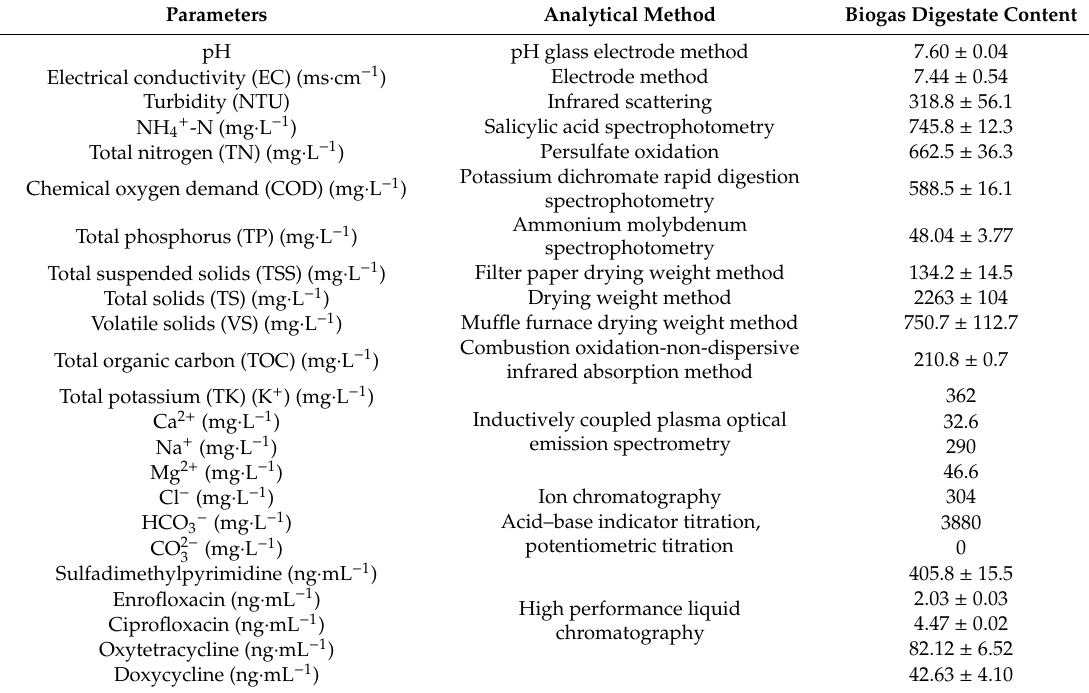
Table 2. The physico-chemical characteristics of swine manure digestate and the methods and equipment used for